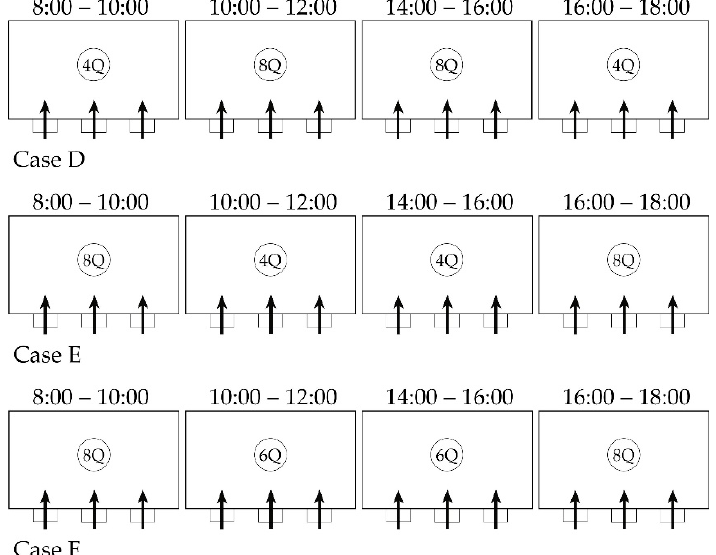
Figure 5. Scheme of the pre-programming horary control of the DSF system, when the airflow rate is variable and the number of DSF to operate is constant.